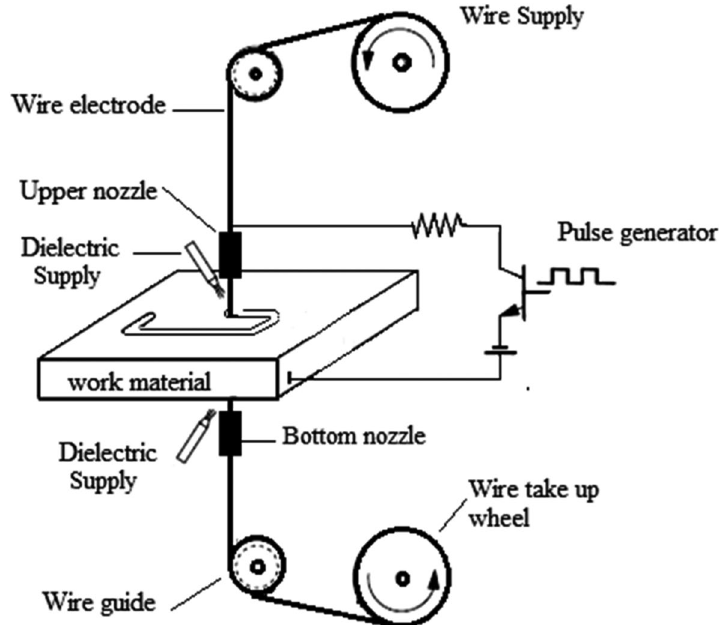
Fig. 2 Basic WEDM Principle